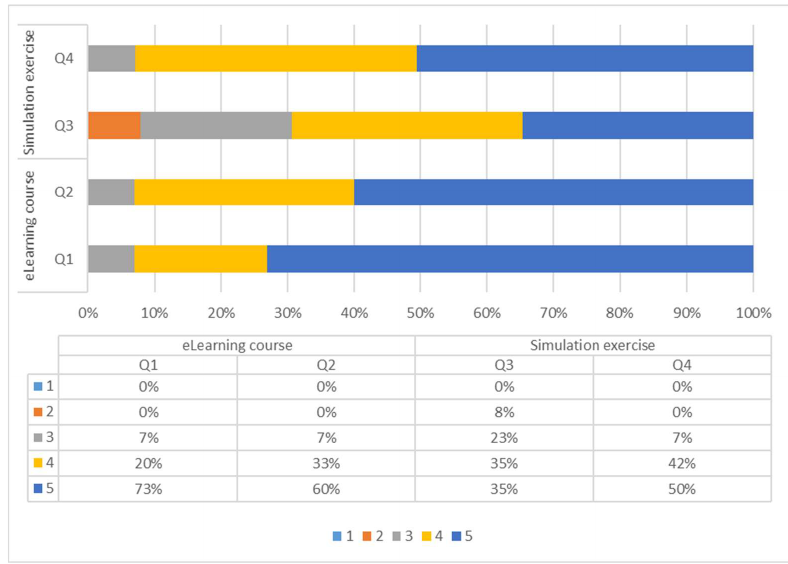
Figure 2. Proportions of the respondents’ scores for the questions concerning the preparatory eLearning course and the simulation exercise: (Q1) What is your general appreciation of the prepar- atory eLearning course? (scale from 1 = low to 5 = high); (Q2) please evaluate the general quality of the training materials (scale from 1 = low to 5 = high); (Q3) how useful do you consider this event in relation to your daily job? (scale from 1 = not useful to 5 = very useful); (Q4) what is your apprecia- tion of the simulation exercise? (scale from 1 = insufficient to 5 =